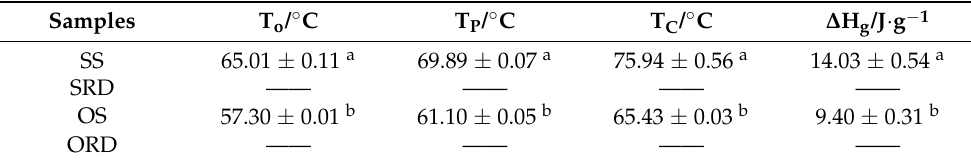
Table 2. DSC profiles of sorghum/oat starch and sorghum/oat resistant dextrin.